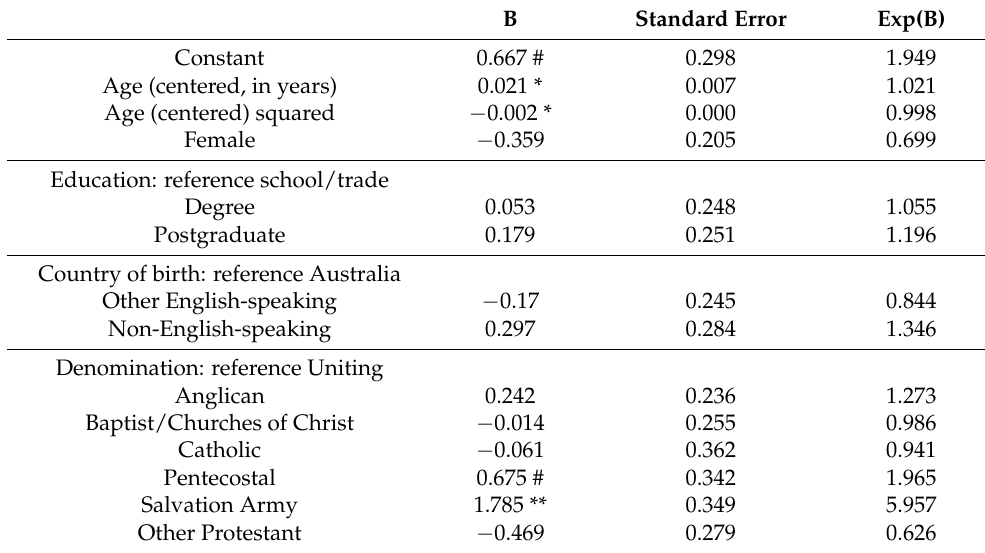
Table 5. Prediction of having dealt with DFV situations from demographics and denomination.